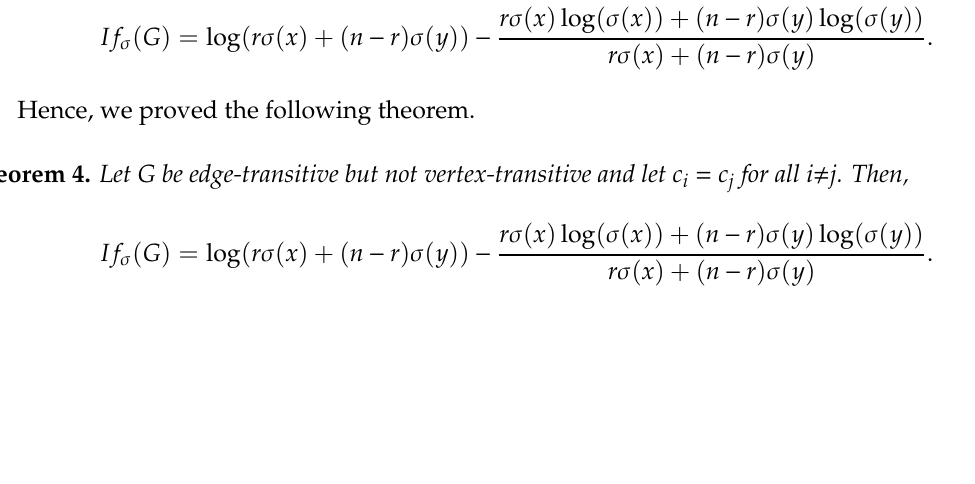
Figure 6. Two-dimensional lattice for T [ p,q ].